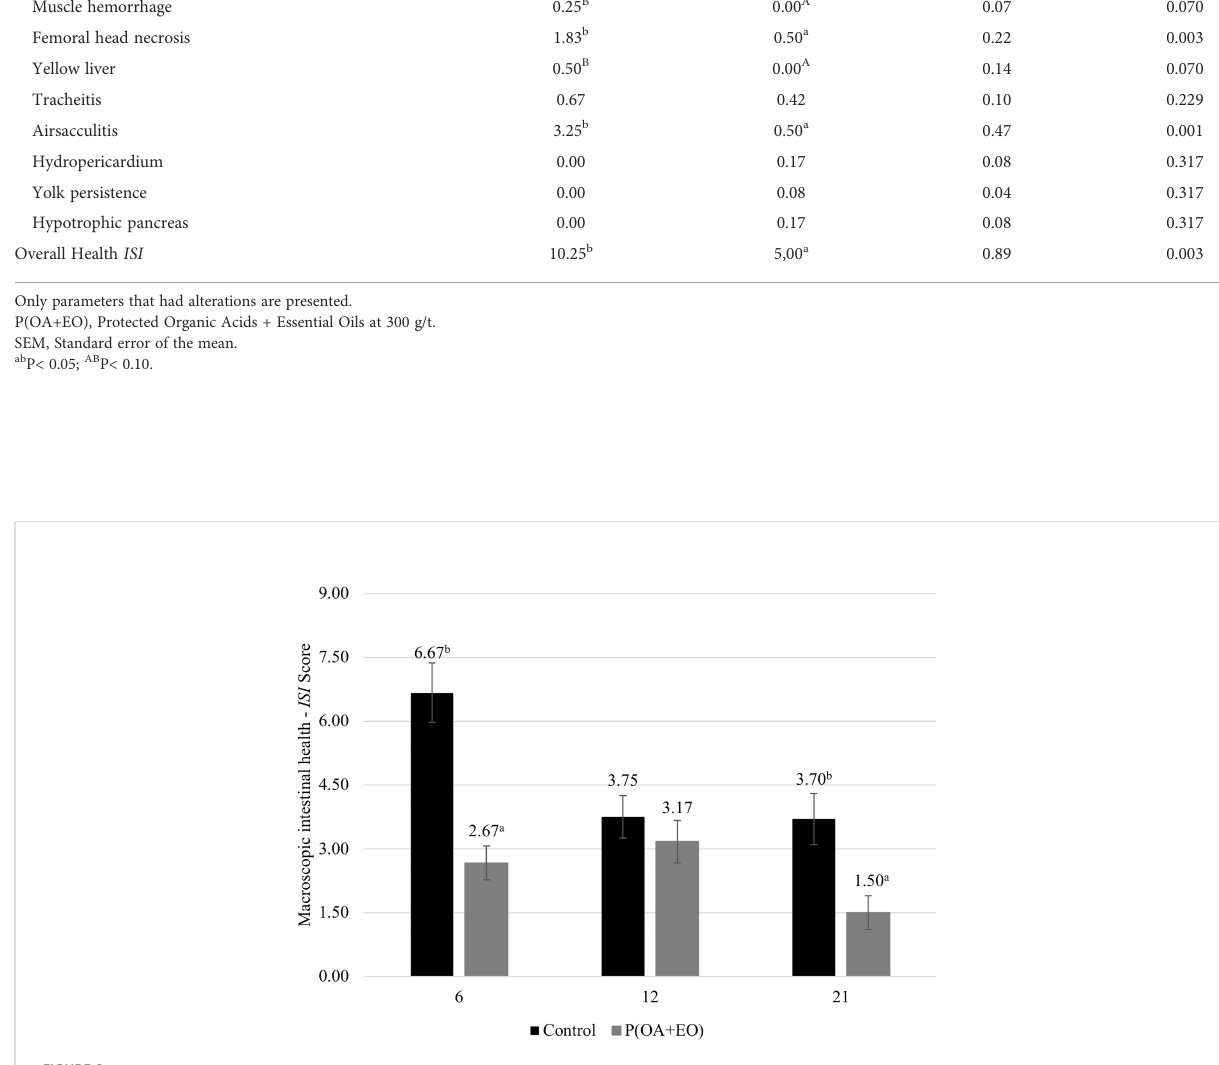
FIGURE 2 Intestinal health analyzed by the macroscopic ISI methodology (sum of the scores given for duodenum, jejunum, ileum, and cecum). Data are the mean value of each treatment at different ages (weeks). ab P<0.05.